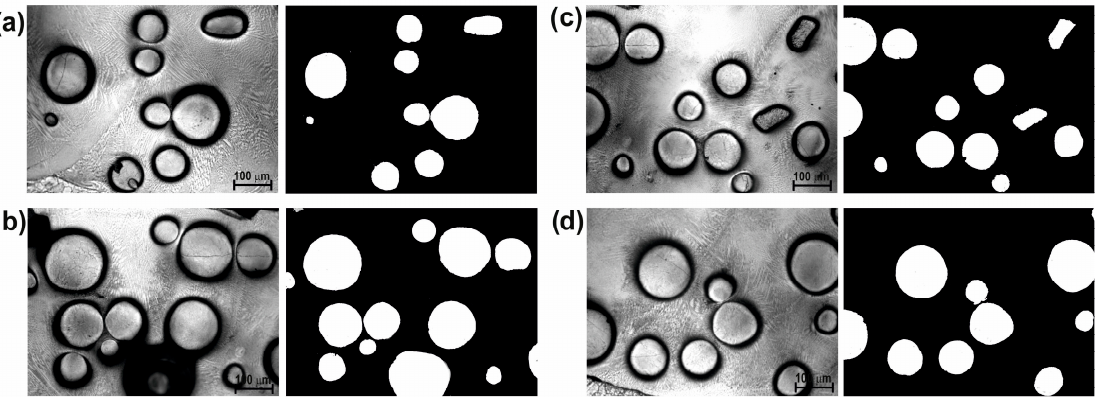
Figure 4. Four selected OM images and their binary images showing the microstructure of the laser-alloyed layer produced with a laser beam power of 1.3 kW: ( a ) area 1, ( b ) area 2, ( c ) area 3, ( d ) area